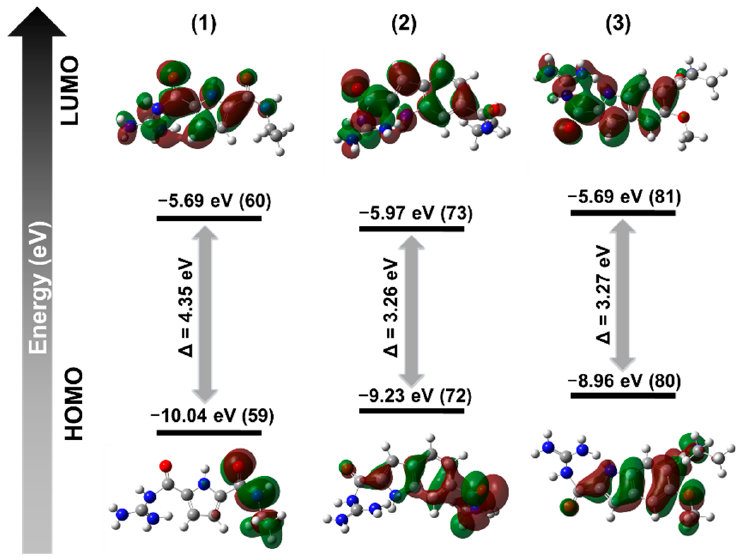
Figure 6. Calculated HOMO/LUMO orbitals and energies of ( 1 ), ( 2 ) and ( 3 Figure 6 . Calculated HOMO/LUMO orbitals and energies of ( 1 ), ( 2 ) and ( 3 ).